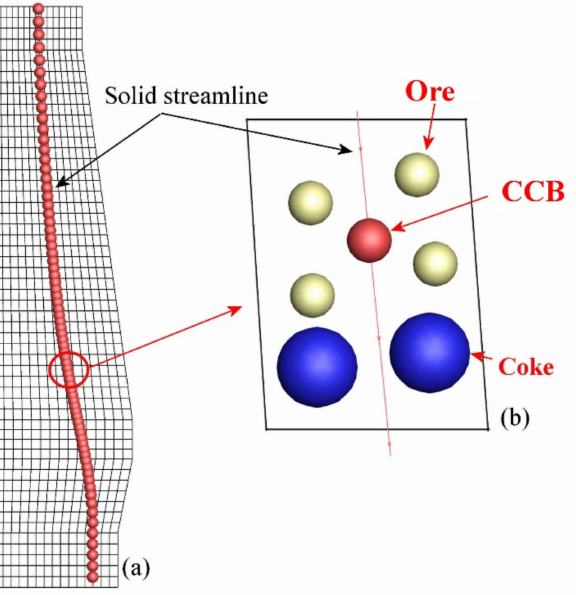
Figure 2. Illustration of Lagrangian method in model: ( a ) solid-flow stream line in BF (blast furnace), and ( b ) illustration of CCB in solid